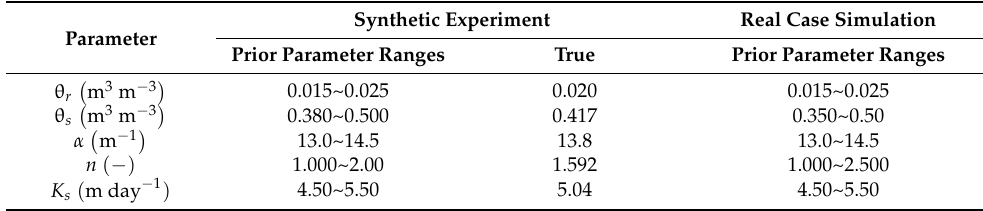
Table 1. Prior ranges of soil hydraulic parameters.